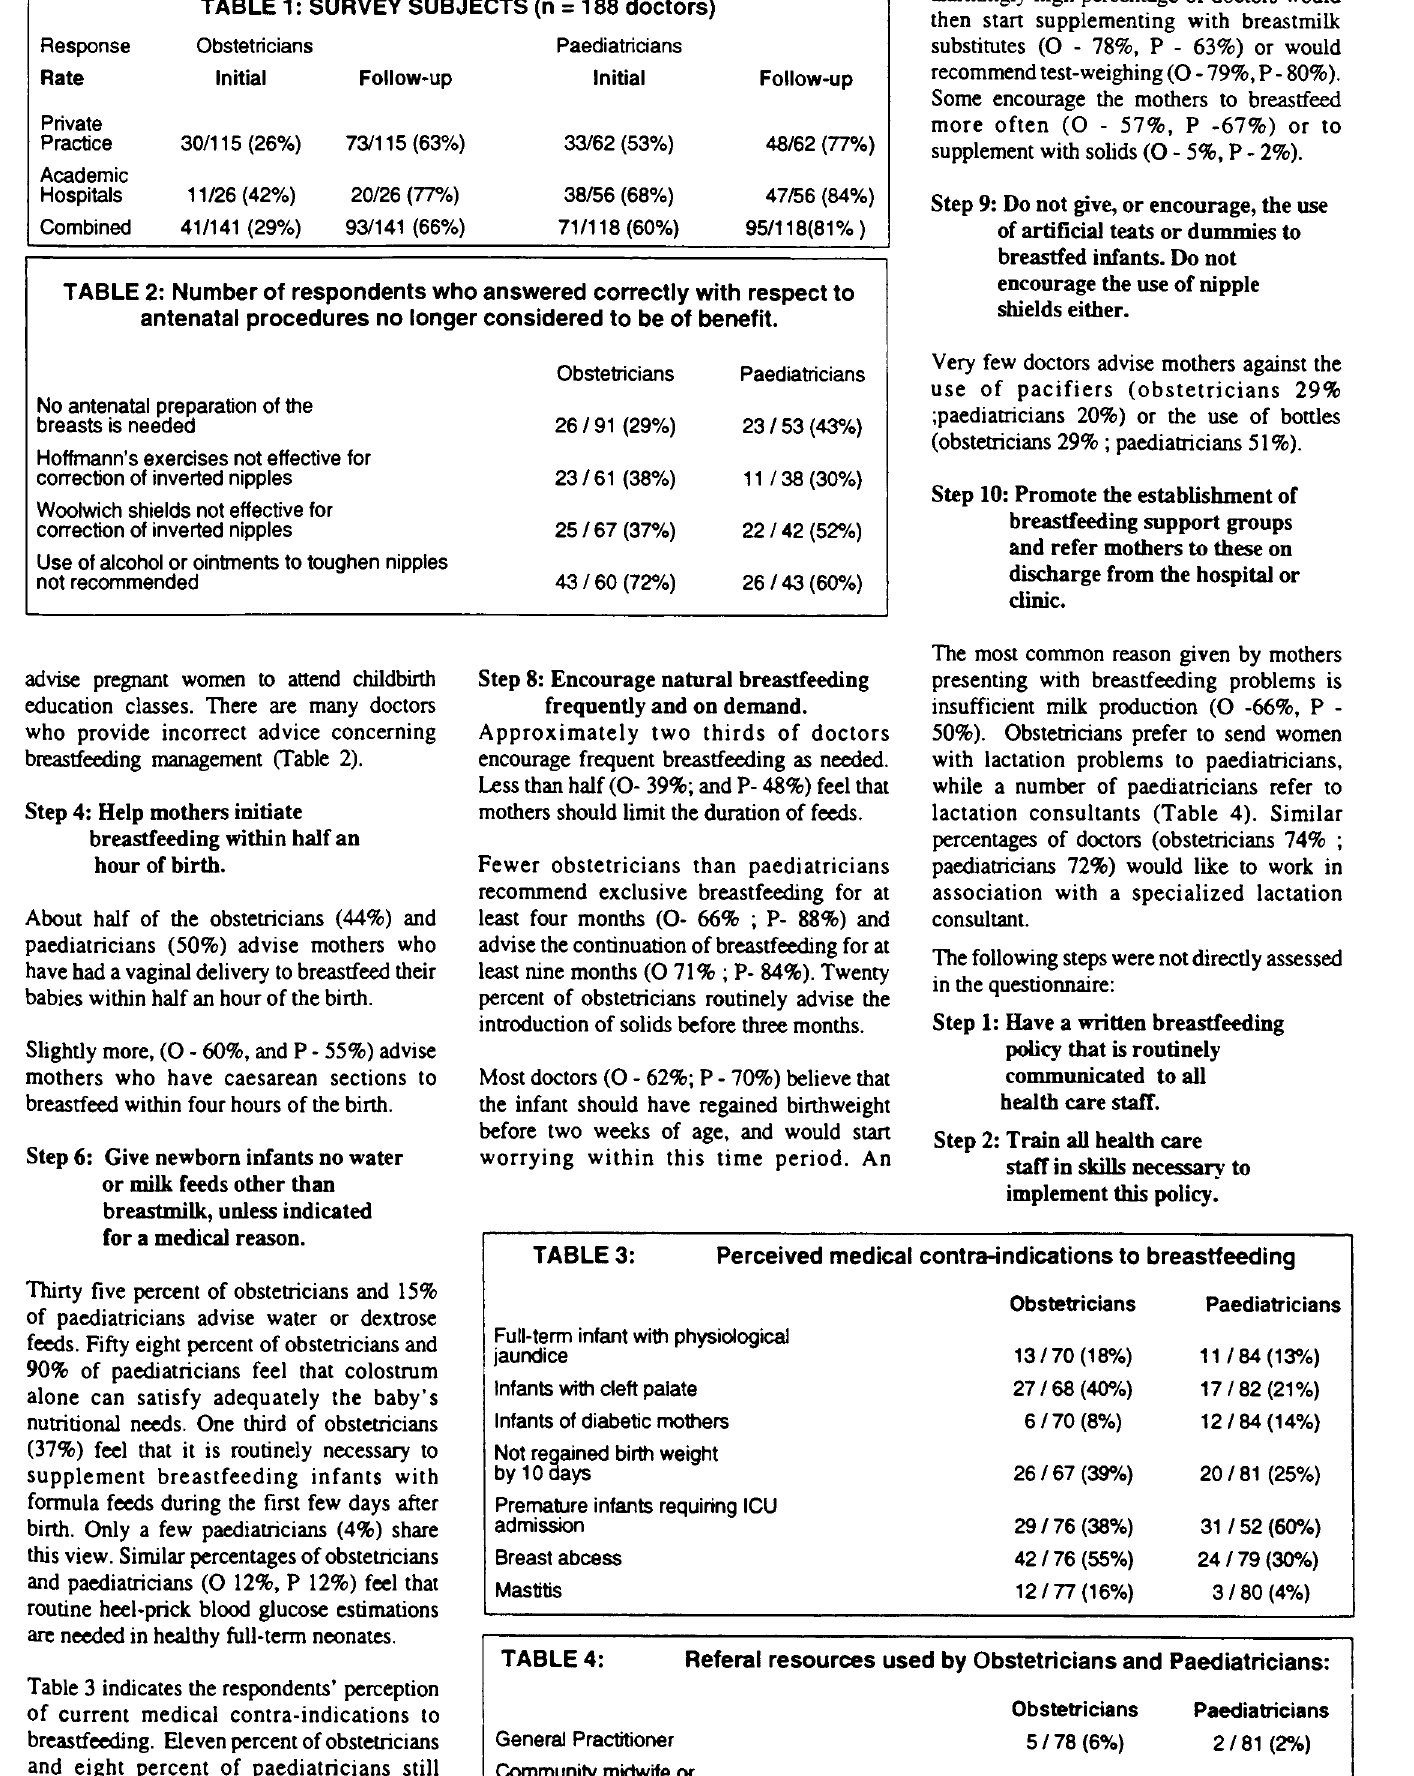
Referal resources used by Obstetricians and